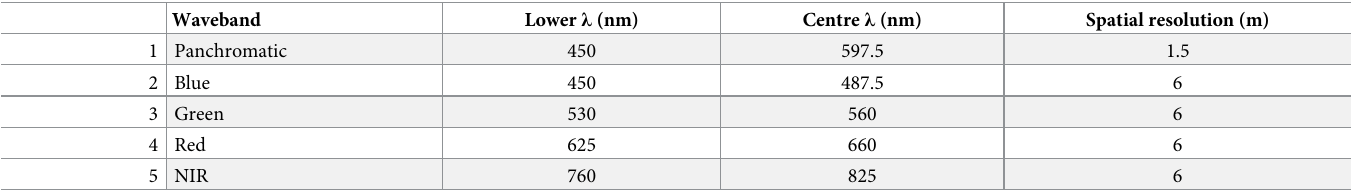
Table 3. Spot-6 wavebands showing the lower, upper and centre wavelength with the resolution of specific bands that make up the image. Waveband Lower λ